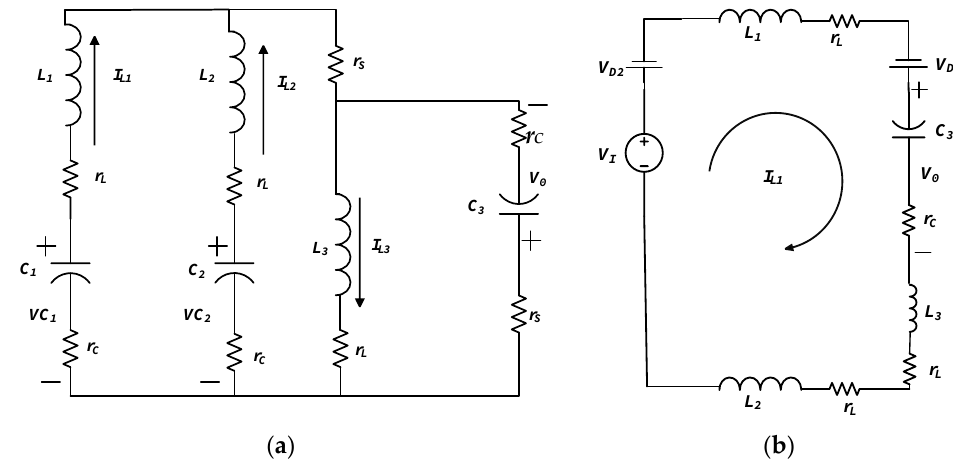
Figure 7. The equivalent current loops with non-ideal elements: ( a ) Mode 1 and ( b ) Mode 2.